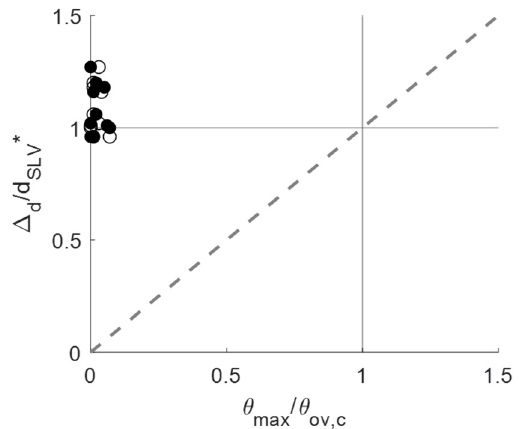
Figure 15. Masonry wall with openings. Comparison of the code-based (equivalent static) and rocking (non-linear dynamic) demand-capacity ratios for the different artificial accelerograms (scaled to a g = 0.35 g).